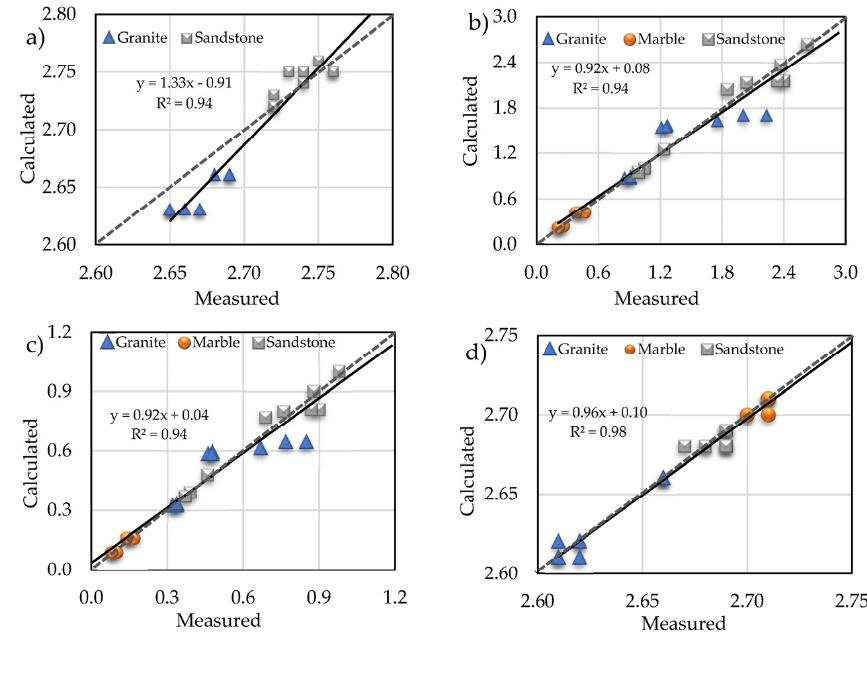
Figure 8. Measured and calculated values of physical properties of the studied rocks obtained from UPV dry ( a ) specific gravity, ( b ) porosity, ( c ) water absorption, and ( d ) dry density.